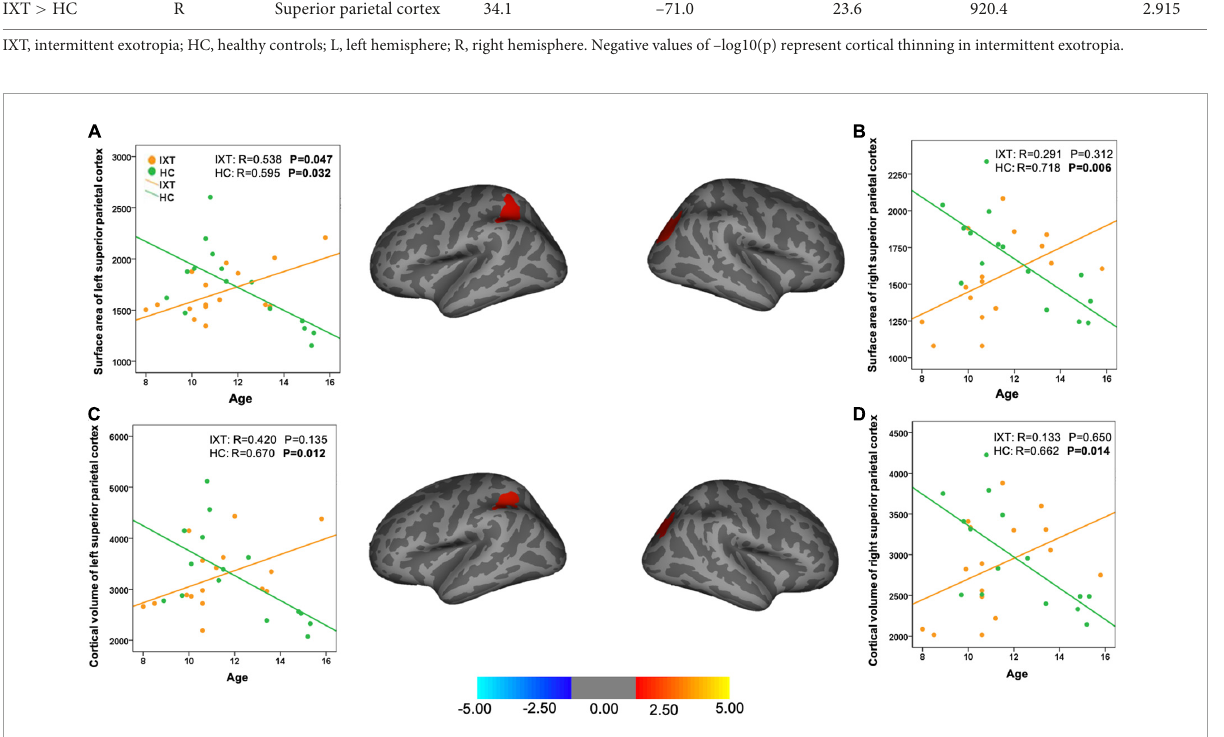
FIGURE2 Brain maps and scatter plots showing statistically significant area-age (A,B) and volume-age (C,D) correlation differences between IXT patients and HC. IXT, intermittent exotropia; HC, healthy controls.